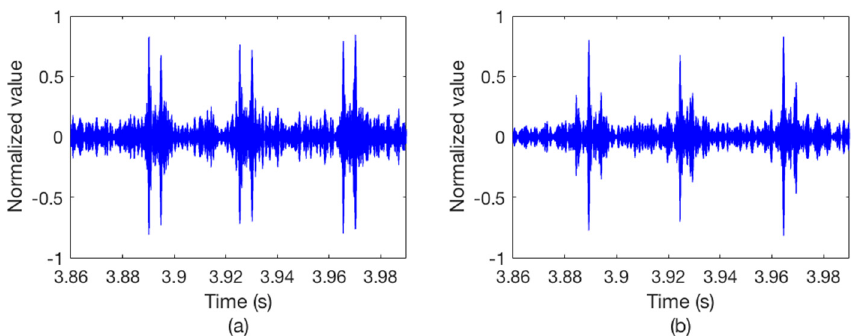
Figure 11. The copy-correlation results of the corresponding data. ( a ) Without TRM; ( b ) with TRM.